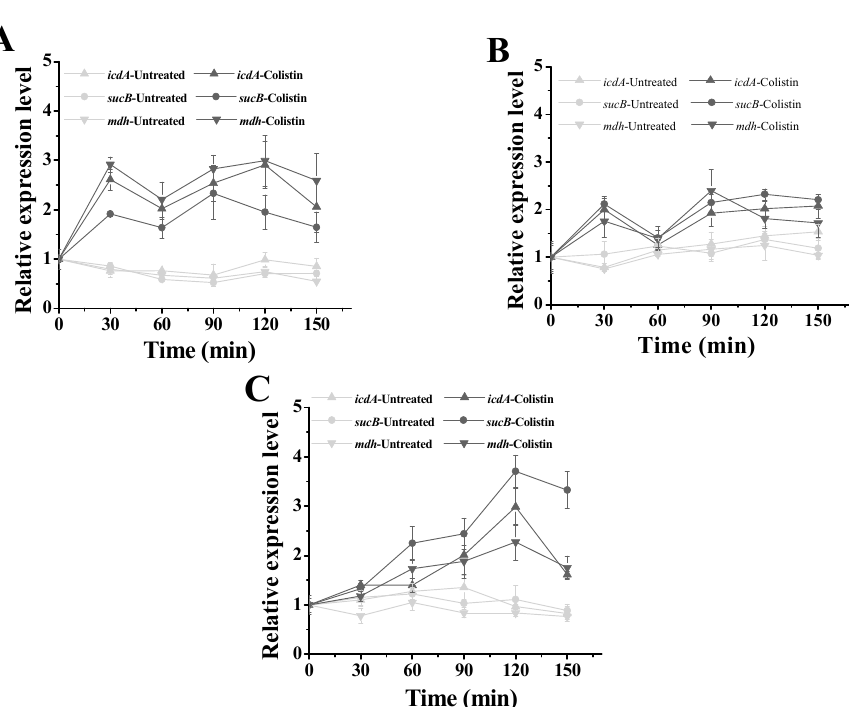
Figure 3. Effect of colistin on relative expression level of genes in the tricarboxylic acid (TCA) cycle. ( A ) Bacillus subtilis WB800; ( B ) Paenibacillus polymyxa C12; ( C ) Paenibacillus polymyxa ATCC842. icdA encoding isocitrate dehydrogenase; sucB encoding α -ketoglutaric dehydrogenase; mdh encoding malate dehydrogenase.